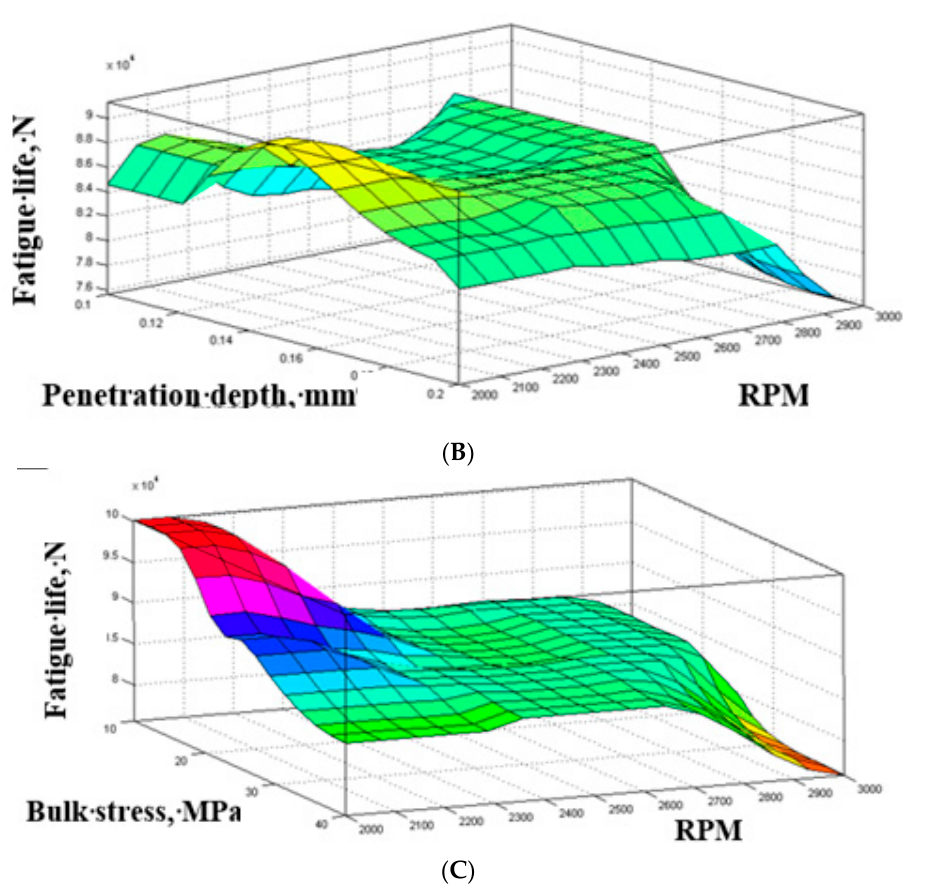
Figure 12. ( A ) Relationships for bending stress, ( B ) relationships for RPM, penetration and fatigue life and ( C ) fatigue life and penetration relationships for bending stress, RPM and fatigue life.